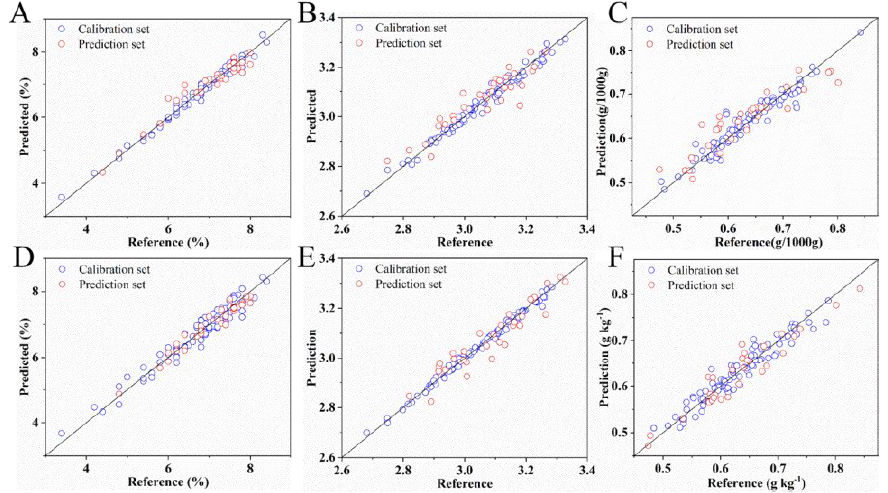
Figure 4. Prediction results of SSC ( A ), pH ( B ), and VC ( C ) using spectral, color, and textural features, and prediction results of SSC ( D ), pH ( E ), and VC ( F ) using important variables of multiple features.